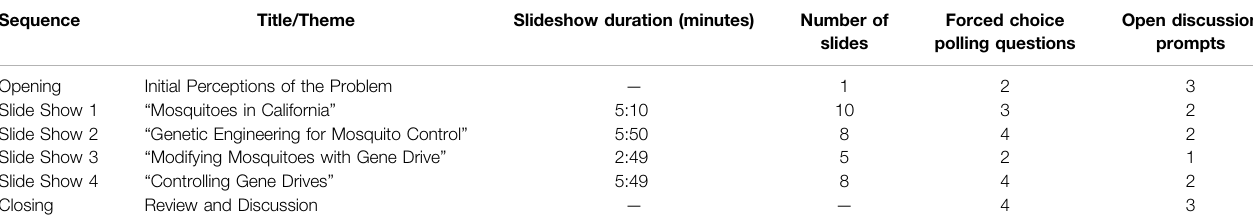
TABLE 1 | Structure of chat-based focus group sessions.